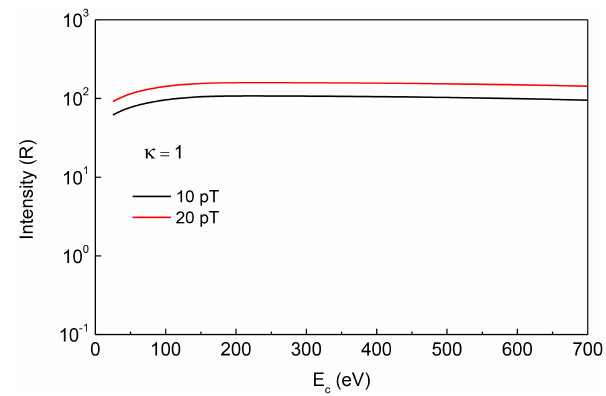
Figure 8. Same as in Fig. 7 for κ = 1.